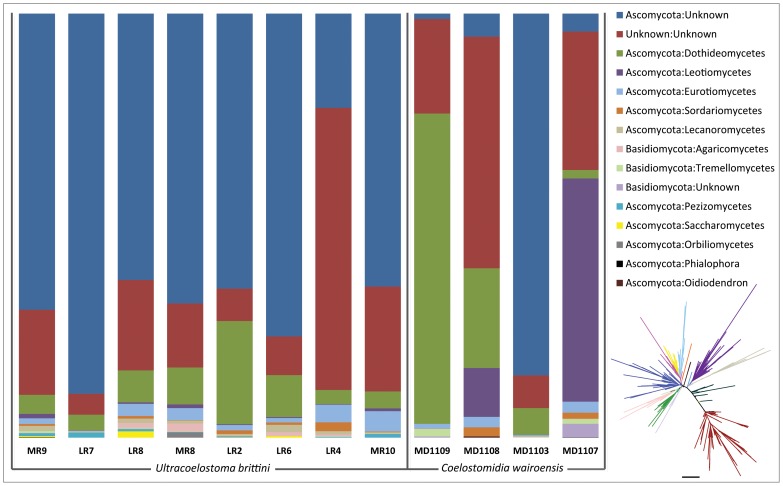
Top 15 most abundant fungal classes represented in the sooty mould ITS-based pyrosequencing dataset.The fungal classes are in order of abundance decreasing from top to bottom, with unknown fungi taking the top two spots, followed by several classes from Ascomycota and Basidiomycota. Representative phylogenetic tree coloured by most abundant fungal classes and others coloured dark teal. Scale bar = 1.0 substitutions/site. Each sample is labelled with Sample IDs from Table 1.